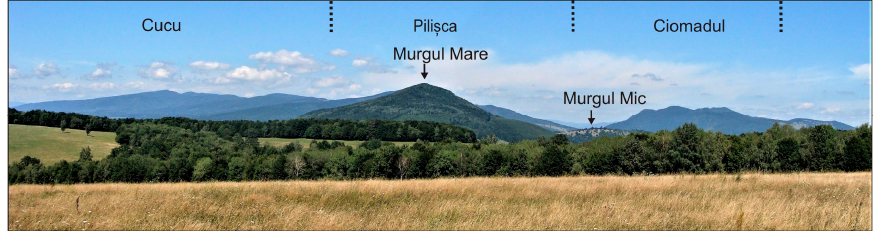
Figure 11. Panoramic view of part of the South Harghita Mountains, as seen from the South (from a hill above Valea Z ă lanului village). The prominent landform in the center of the image is the Murgul Mare dacitic dome masking the Pili ș ca volcano behind. Cucu volcano can be seen in the background to the left, and Ciomadul volcano’s central dome cluster in the background to the right. (Photo: Alexandru Szakács).